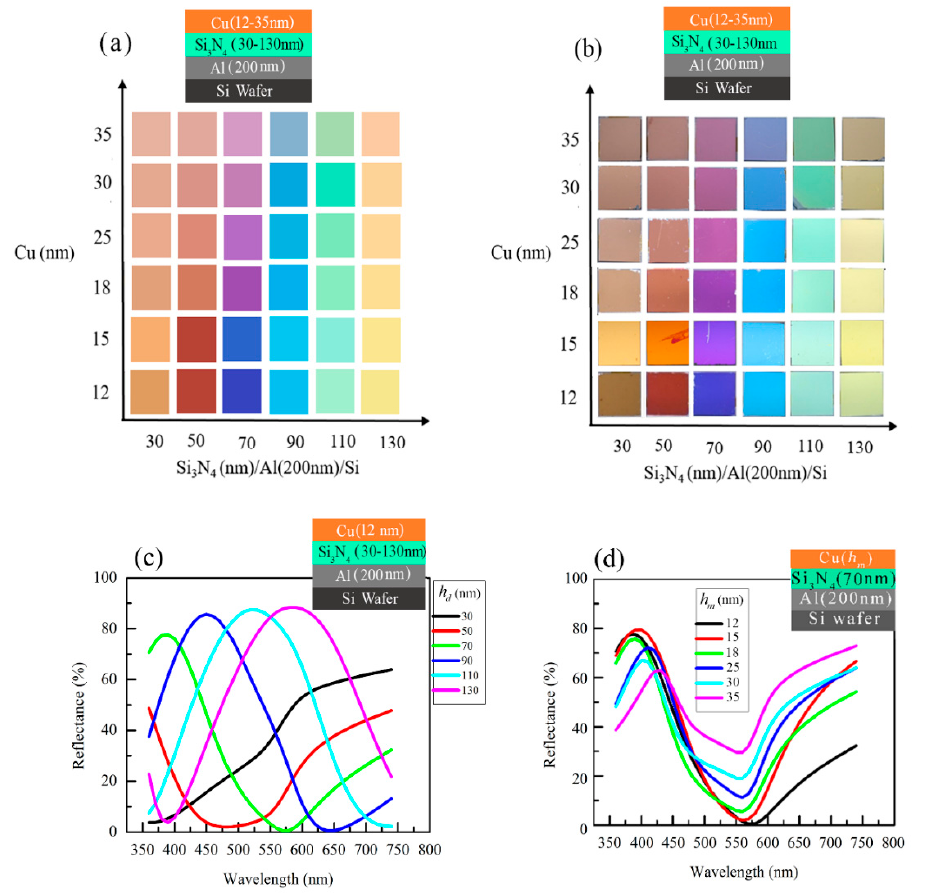
Figure 1. ( a ) The measured structural color of the Cu( h m ) /Si 3 N 4 ( h d )/Al (200 nm)/Si structures with varying h m = 12–35 nm and h d = 30–130 nm in the step of 20 nm. ( b )The camera images of the same. The dependencies of the reflectance spectra with varying ( c ) The dependencies of the reflectance spectra with varying h d in Cu (12 nm)/Si 3 N 4 ( h d )/Al (200 nm)/Si structures and ( d ) h m in Cu ( h m ) /Si 3 N 4 (70 nm)/Al (200 nm)/Si structures.